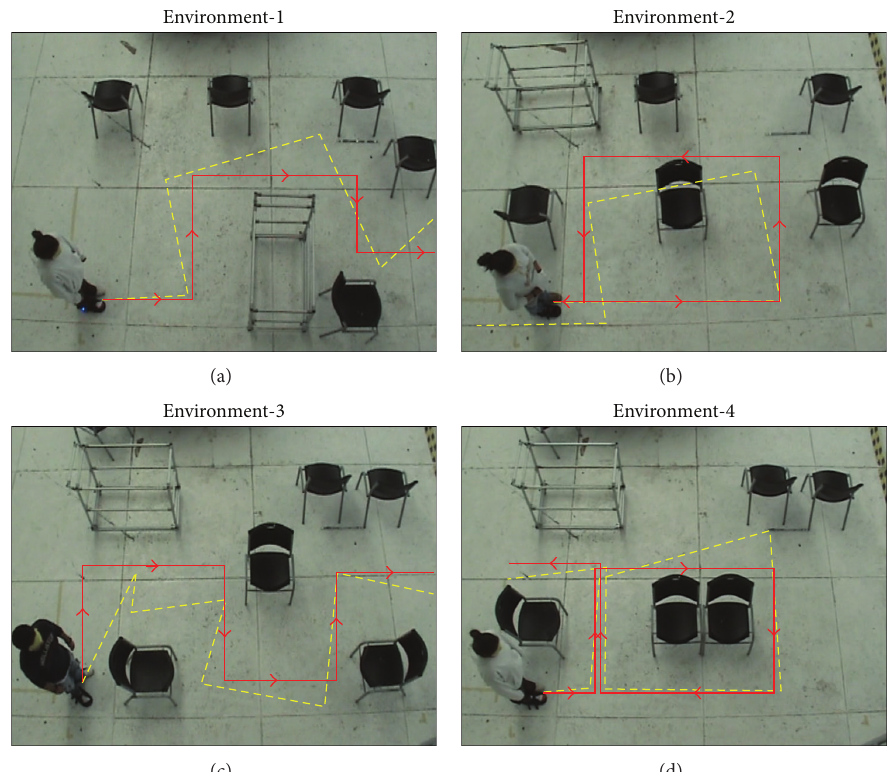
Figure 7: Examples of subject performance in the navigation task. The solid red line represents the ideal trajectory traced by the guiding computer. The broken yellow line is the actual trajectory followed.